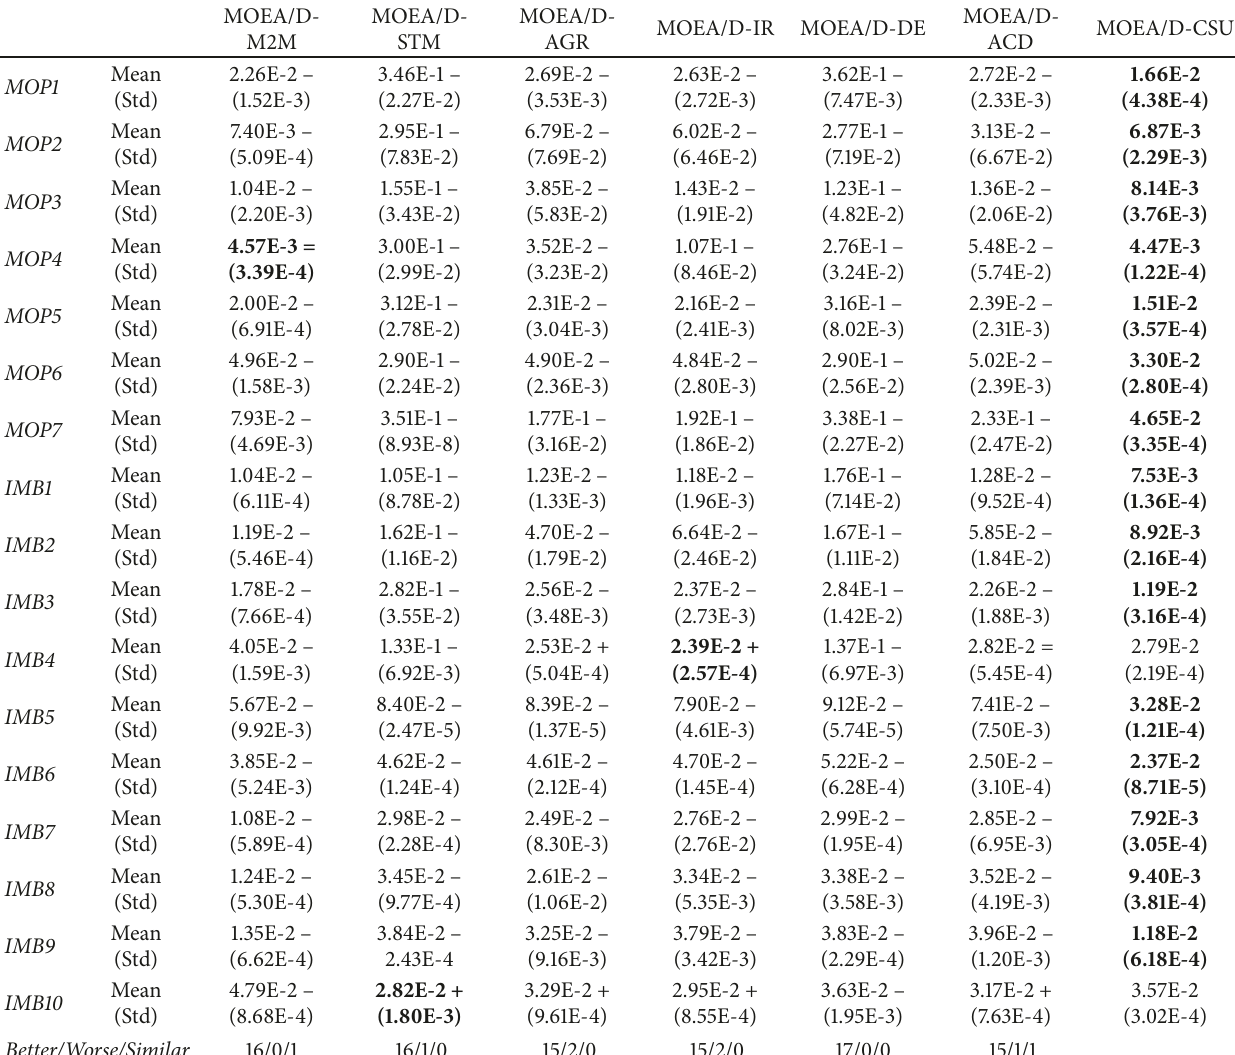
Table 1: IGD comparison of results of MOEA/D-CSU and six competitors on all the MOP and IMB test